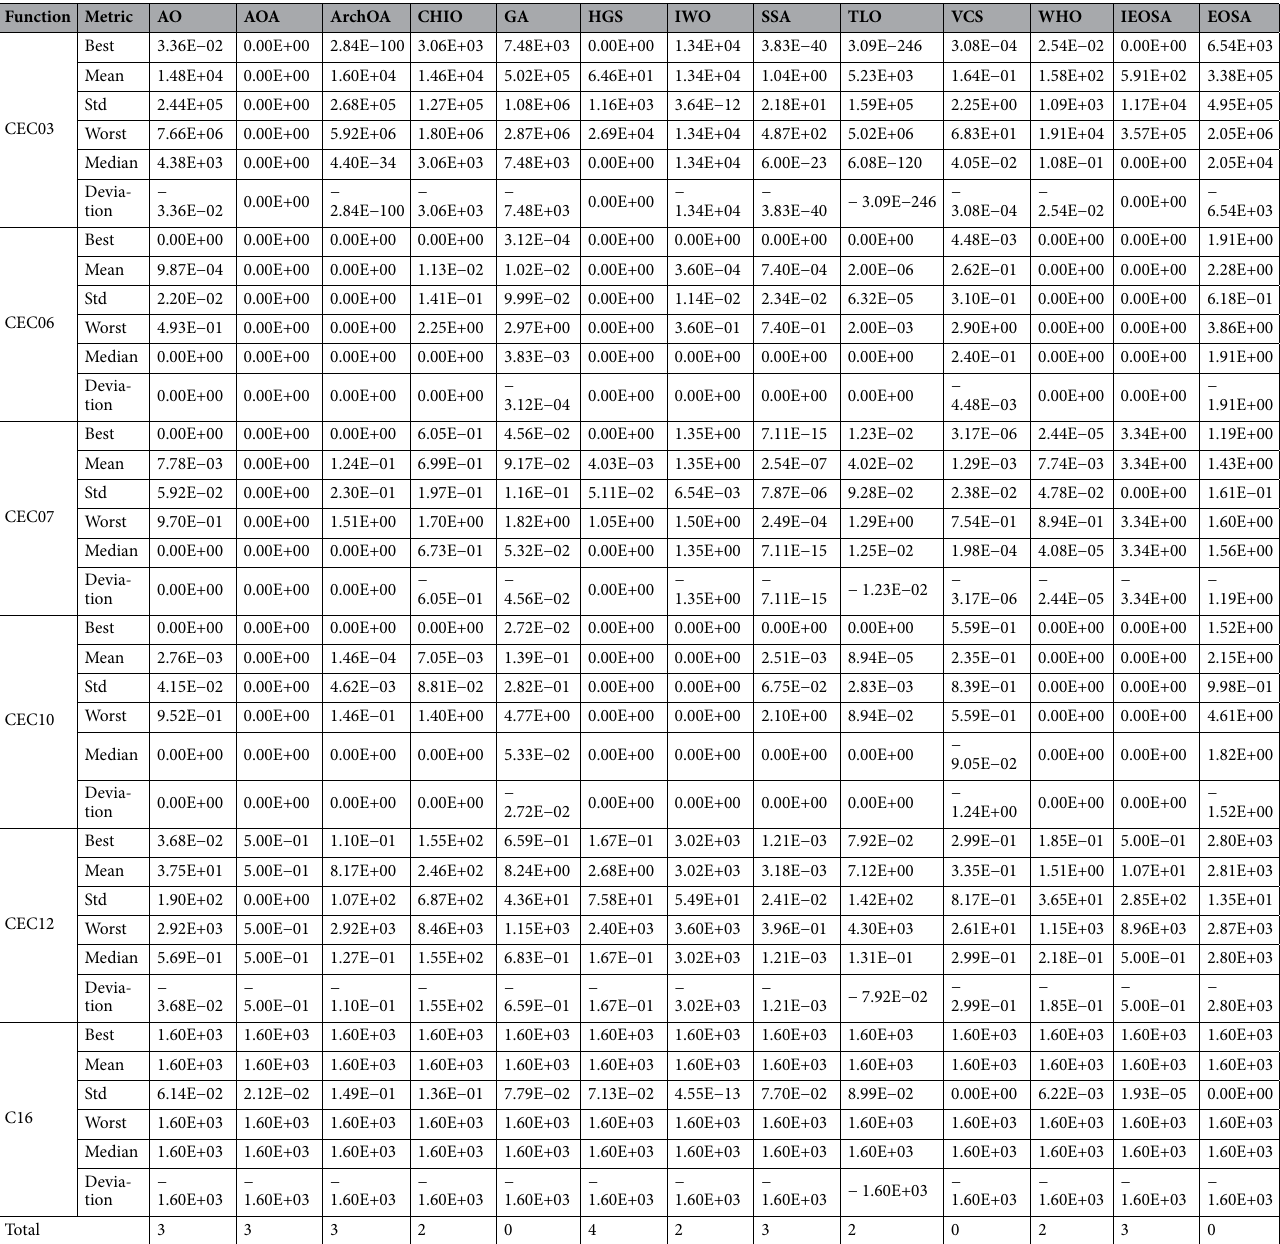
Table 5. Performance evaluation of AO, AOA, ArchOA, CHIO, GA, HGS, IWO, SSA, TLO, VCS, WHO, EOSA, and IEOSA using five (5) IEEE CEC constraint benchmark